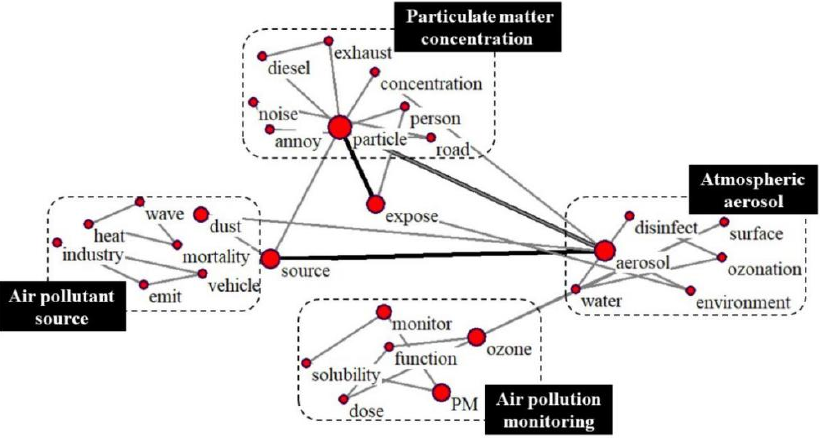
Figure 8. Group II research topics .